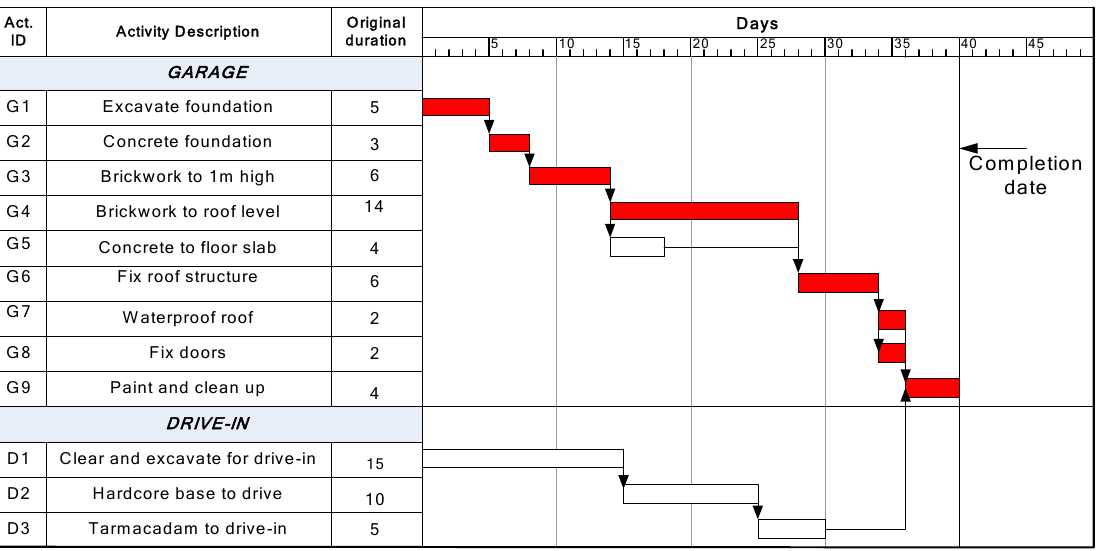
Figure 2. As-planned schedule.